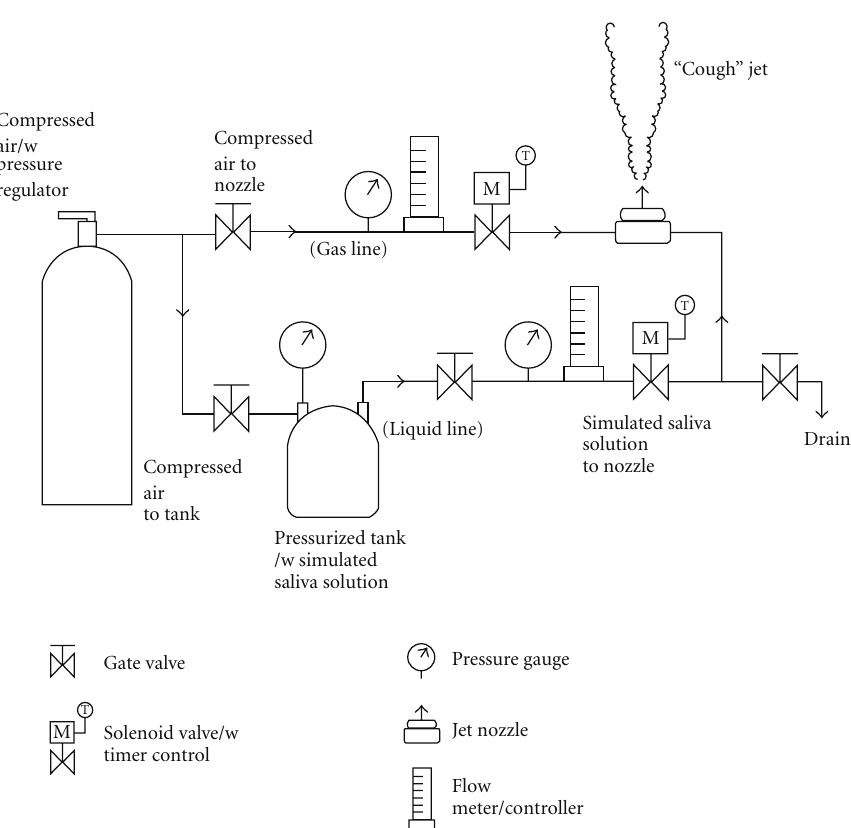
Figure 11: Inhouse-made polydispersed particle generator, built to mimic expiratory droplets produced during human coughing [48].